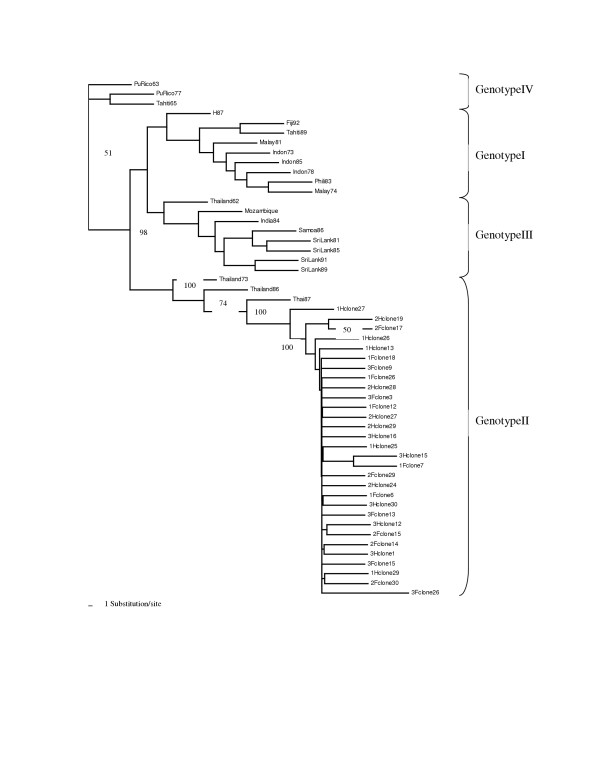
Phylegenetic tree showing the evolutionary relationships of the E gene among 54 sequences from 30 clonal sequences of 6 DEN-3 clinical isolates and 24 global isolates. Bootstrap support values presented as percentage are given for key nodes only and the genotype designations are given. The horizontal branch length of the trees was drawn to scale. GenBank accession numbers of the global DEN-3 strains used in this analysis are as follows: Fiji92 (L11422), India84 (L11424), Indonesia73 (L11425), Indonesia78 (L11426), Indonesia85 (L11428), Malaysia74 (L11429), Malaysia81 (L11427), Mozambique85 (L11430), H87 (L11423), Philippines83 (L11432), Puerto Rico77 (L11434), Puerto Rico63 (L11433), Samoa86 (L11435), SriLanka81 (L11431), Sri Lanka85 (L11436), Sri Lanka89 (L11437), Tahiti65 (L11439), Tahiti89 (L11619), Thailand62 (L11440), Thailand73 (L11620), Thailand87 (L11442).